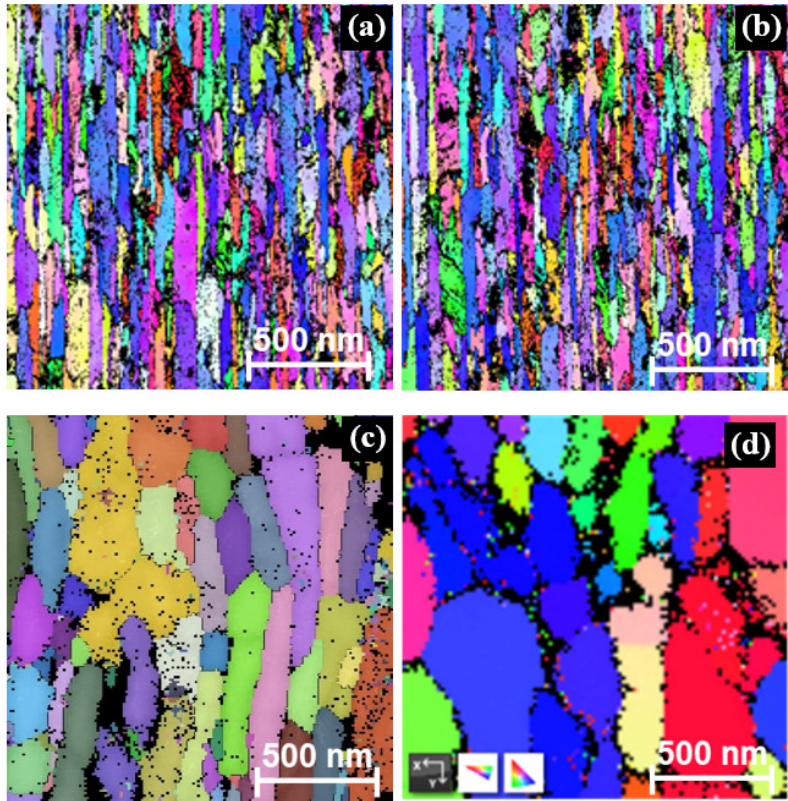
Figure 2. The IPF maps of the cold spray deposited coating show elongated and deformed grains in ( a ) as-deposited conditions, while recrystallized grains are identified in heat-treated at ( b ) 200 °C, ( c ) 300 °C, and ( d ) 400 °C conditions.